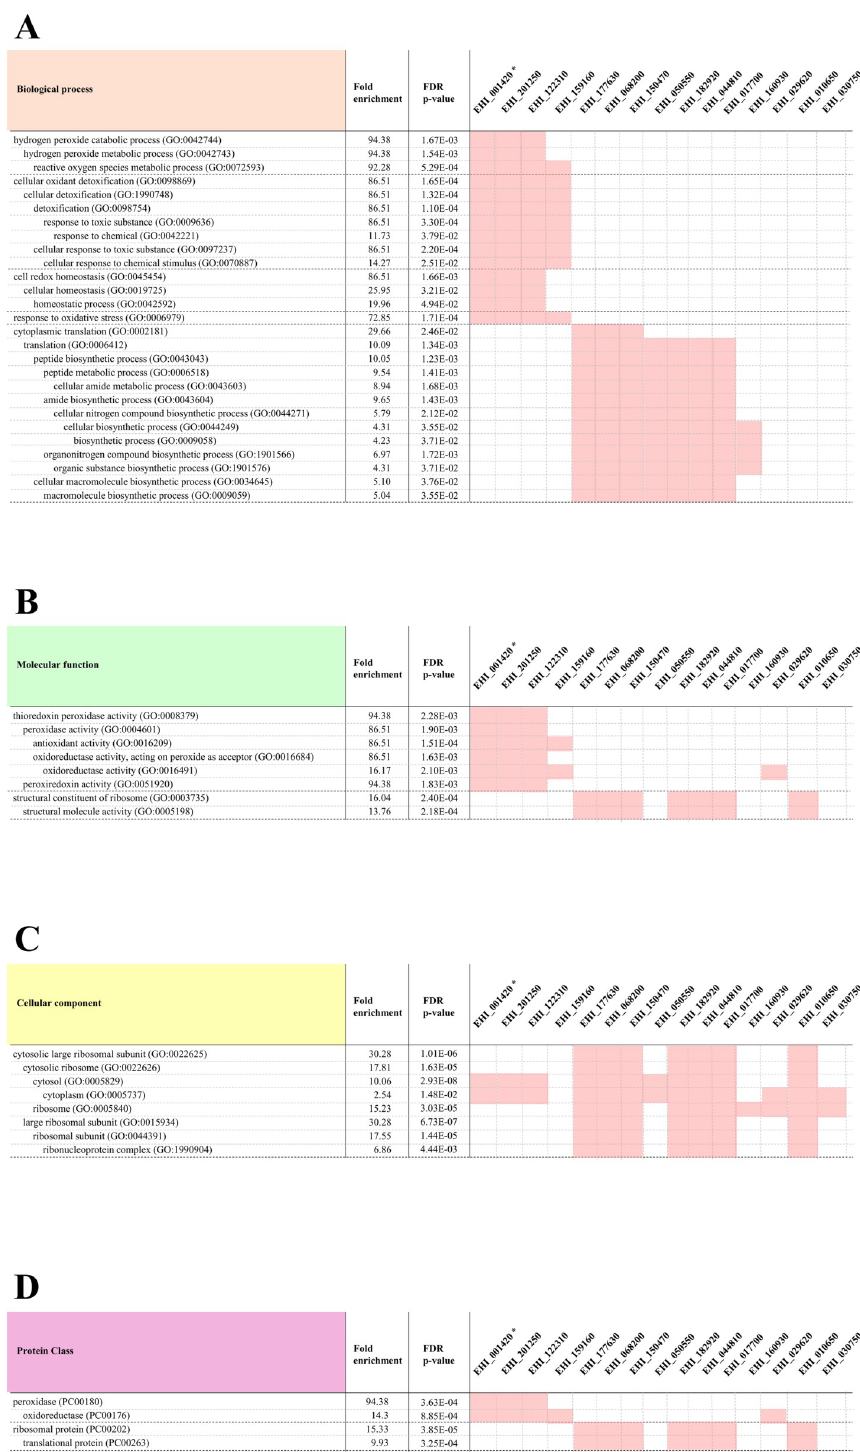
Fig 4. Clustering of 15 multi-functional genes among the 26 DEGs that are inversely up- or down-regulated between strains Ax19 and Ax11. (A) Biological process. (B) Molecular function. (C) Cellular component. (D) Protein Class. � EHI_001420 gene was identified in the gene lists for five overlapping genes between the 91 Ax19 strain-specific DEGs and the 85 Ax19 environment-specific DEGs (S9 Data).